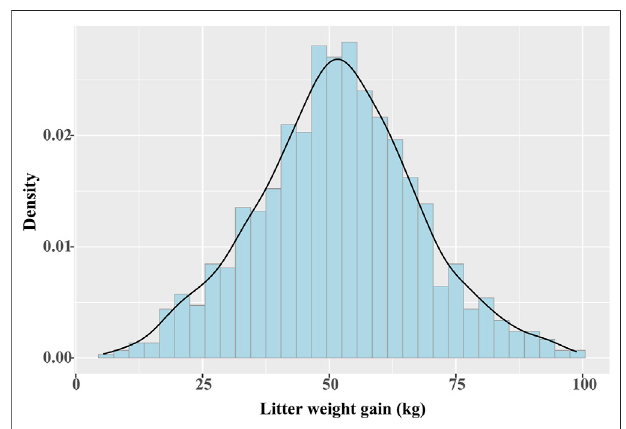
FIGURE 1 | Distribution of milk production ability for 985 Yorkshire